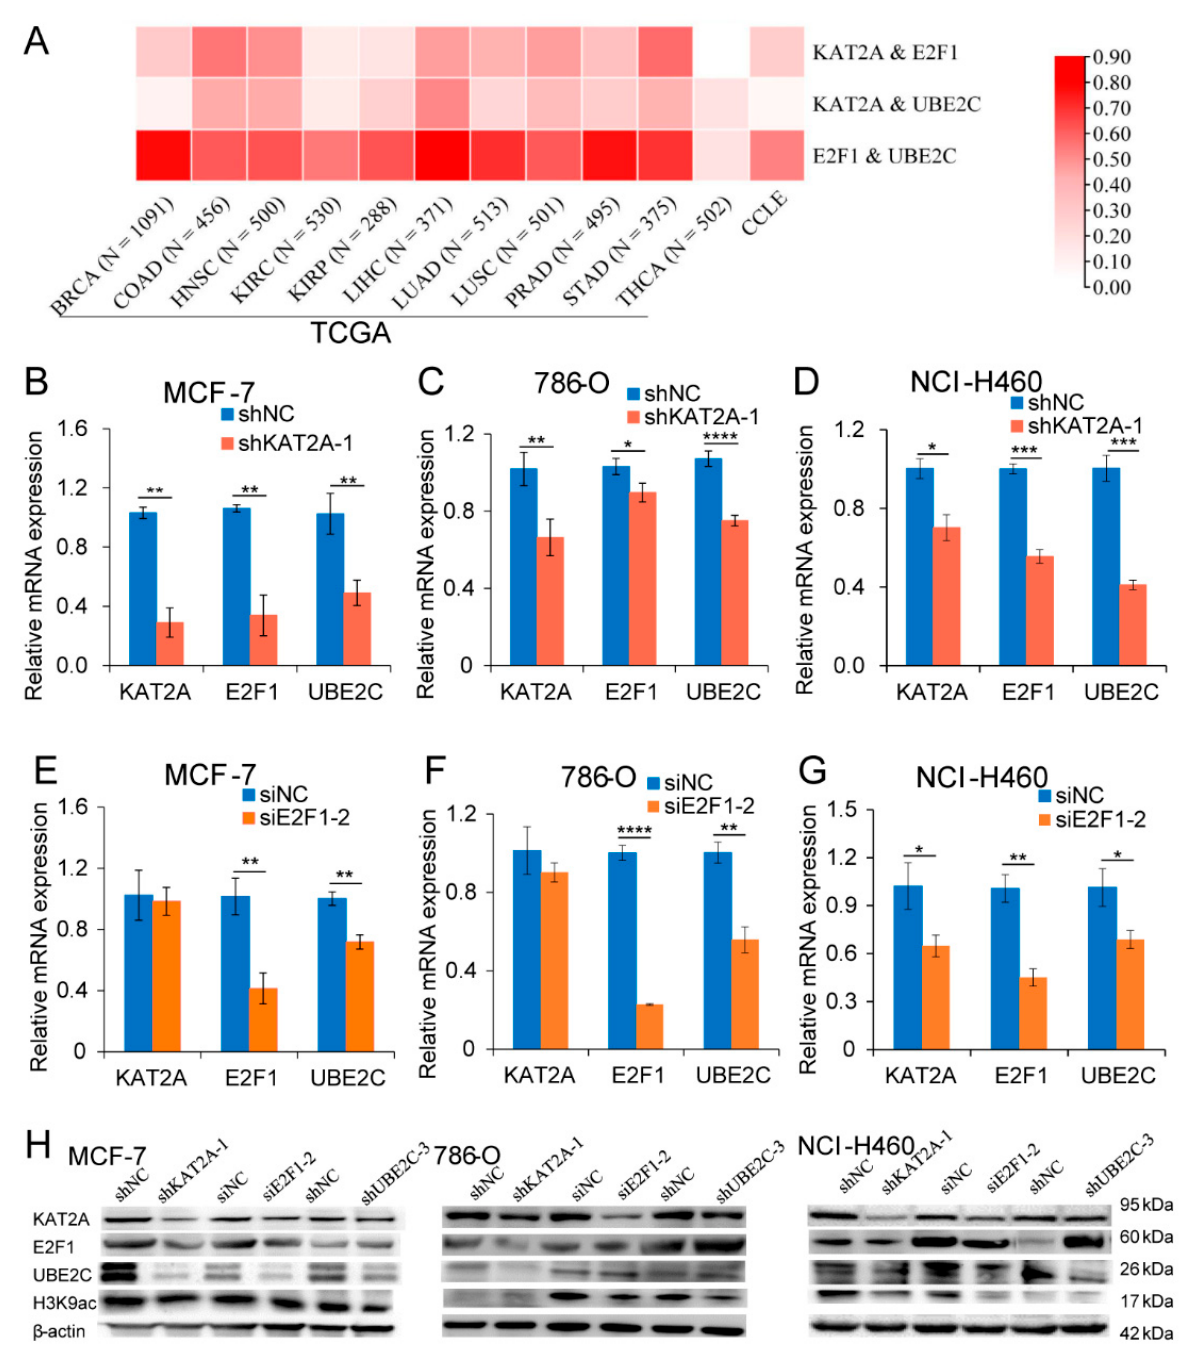
Figure 3. Both KAT2A and E2F1 could regulate the expression of UBE2C in different cancers. ( A ) The correlation coefficient between KAT2A , E2F1 , and UBE2C in different cancers. ( B – D ) The expression levels of KAT2A , E2F1 , and UBE2C were detected by qRT-PCR after interference with KAT2A and NC in MCF-7 ( B ), 786-O ( C ), and NCI-H460 ( D ) cells. ( E – G ) qRT-PCR detected the expression levels of KAT2A , E2F1 , and UBE2C after interference with E2F1 and NC in MCF-7 ( E ), 786-O ( F ), and NCI-H460 ( G ) cells. Data are representative from at least three independent experiments. N = 3. The statistical significance was analyzed by Student’s t -test (one-tailed) analysis. ( H ) After interfering with KAT2A , E2F1 , and UBE2C and their corresponding NC, the expression levels of their encoded proteins in MCF-7, 786-O, and NCI-H460 cells were detected using Western blot, respectively. N = 1. *: p < 0.05; **: p < 0.01; ***: p < 0.001; ****: p < 0.0001.